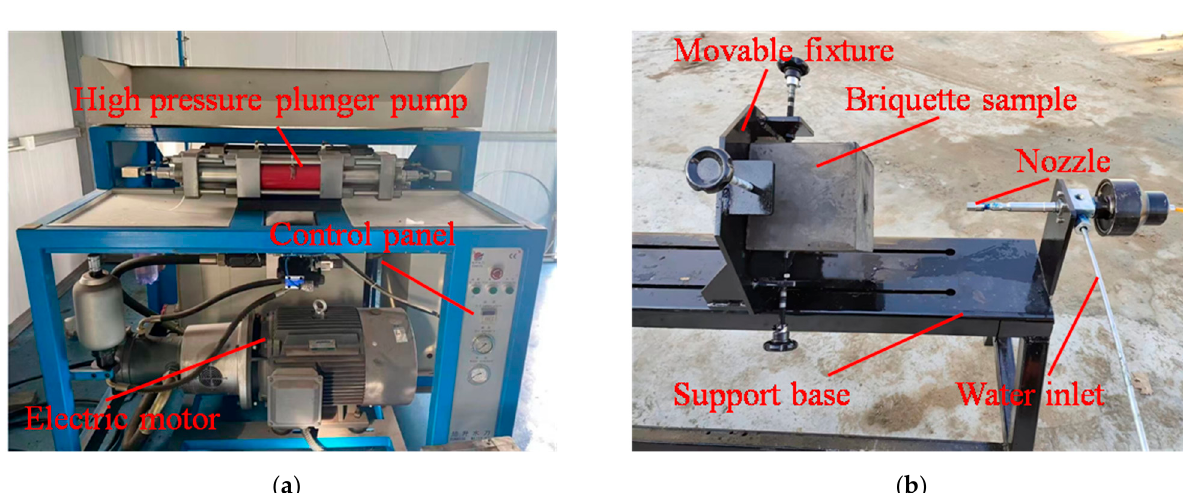
Figure 13. Experiment equipment: ( a ) pumping station;( b ) equipment of the water jet.